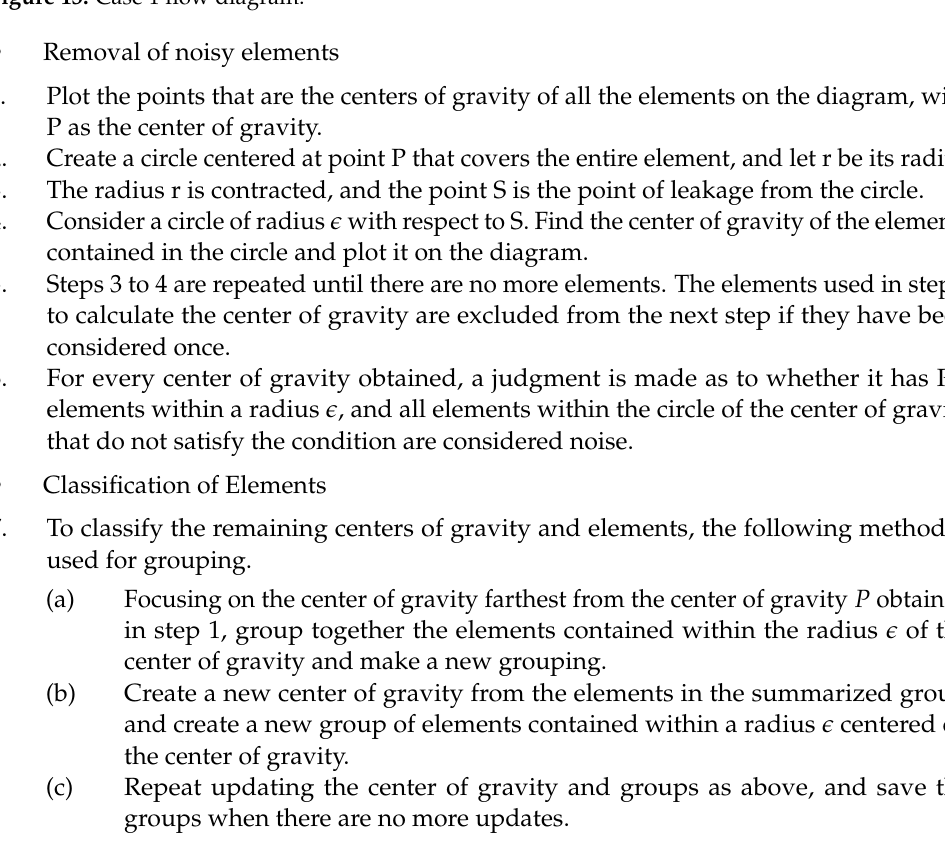
Figure 13. Case 1 flow